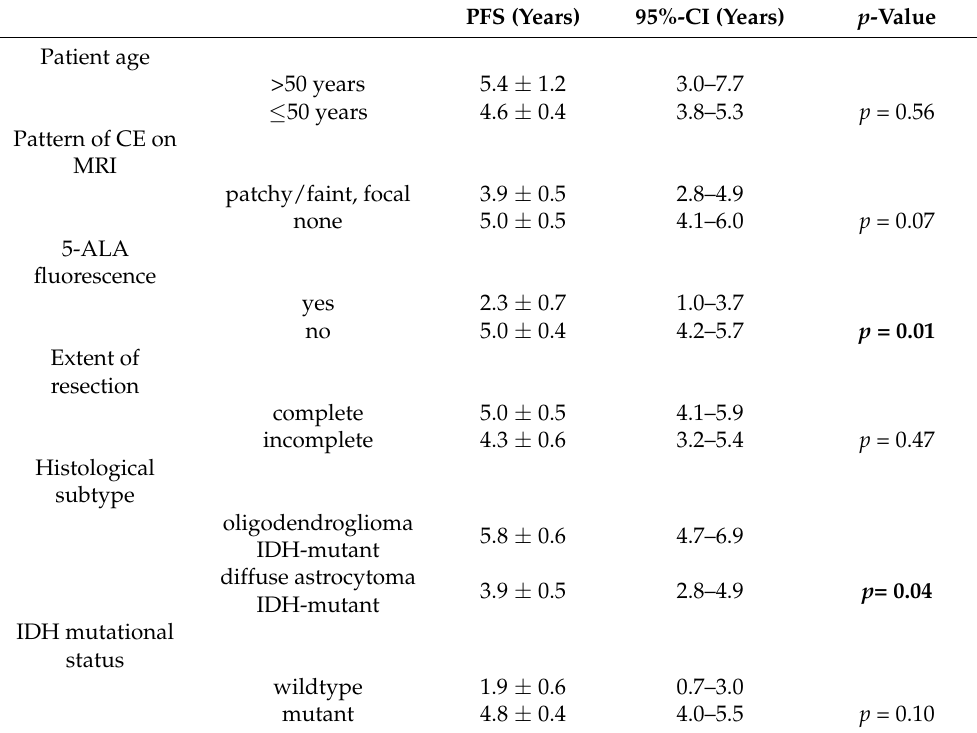
Table 2. Progression-free